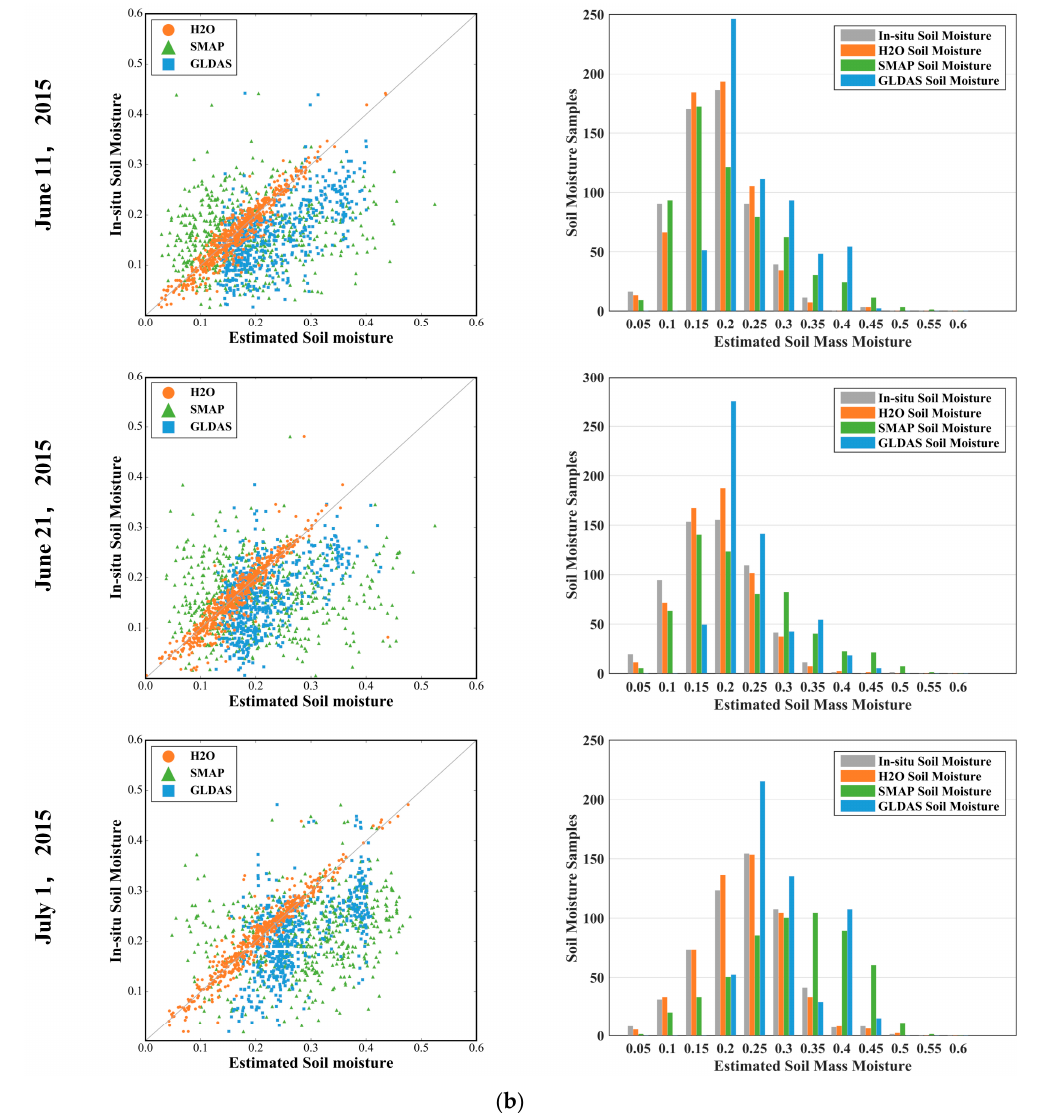
Figure 7. ( a ) Comparison of the performance of three types of soil moisture estimates and in situ soil moisture measurements on 11 May, 21 May and 1 June 2015. ( b ) Comparison of the performance of three types of soil moisture estimates and in situ soil moisture measurements on 11 June, 21 June and 1 July 2015. In Figure 7, where the panels on the left show the 1:1 scatter plots of three types of soil moisture estimates compared to in situ soil moisture measurements. The panels on the right are the corresponding distribution histograms of the soil samples on the six days. The H2O models distribution pattern of their soil samples displayed the same trend. At the same time, the majority of the SMAP soil moisture values have a range of 0.15–0.25, indicating a systematic over-estimation problem compared to the in situ soil moisture measurements. One possible reason is that the measurement unit of the SMAP soil moisture is cm 3 /cm 3 (water volume divided by water and soil volume), which differs from that of in situ soil moisture, i.e., g/g (water weight divided by water and moisture multiplied by the density of water and soil. Strictly speaking, the density of the water and